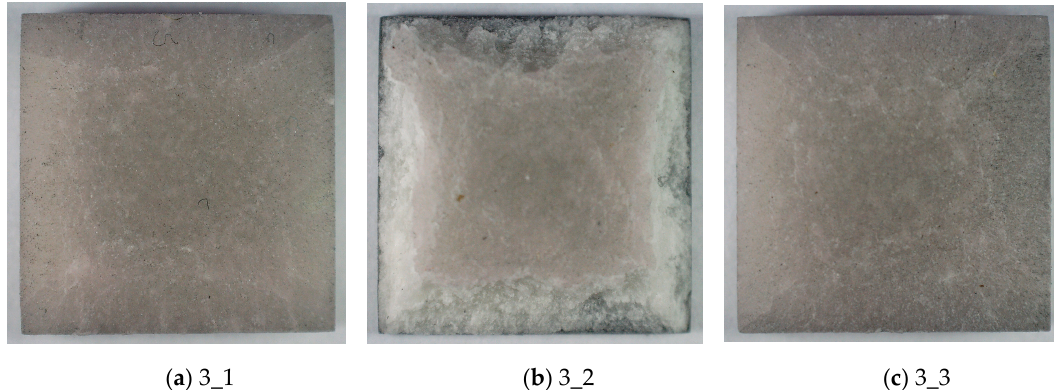
Figure 7. Internal structure of the TBC/PMC sample after impact with the pressure of 1 bar: ( a ) the TBC ceramic mat; ( b ) cross-section of the sample.